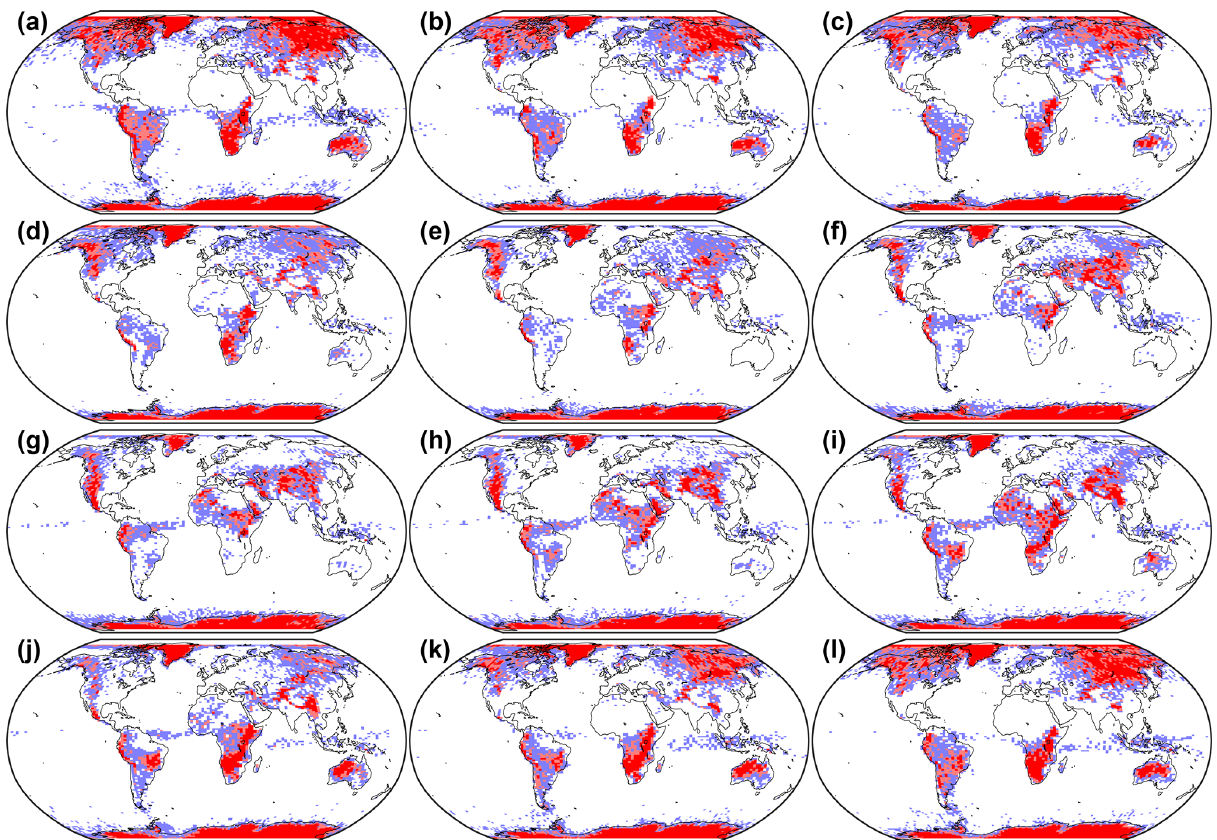
Figure A8. Same as Fig. 9b but for individual months: (a) January, (b) February, (c) March, (d) April, (e) May, (f) June, (g) July, (h) August, (i) September, (j) October, (k) November, and (l) December.